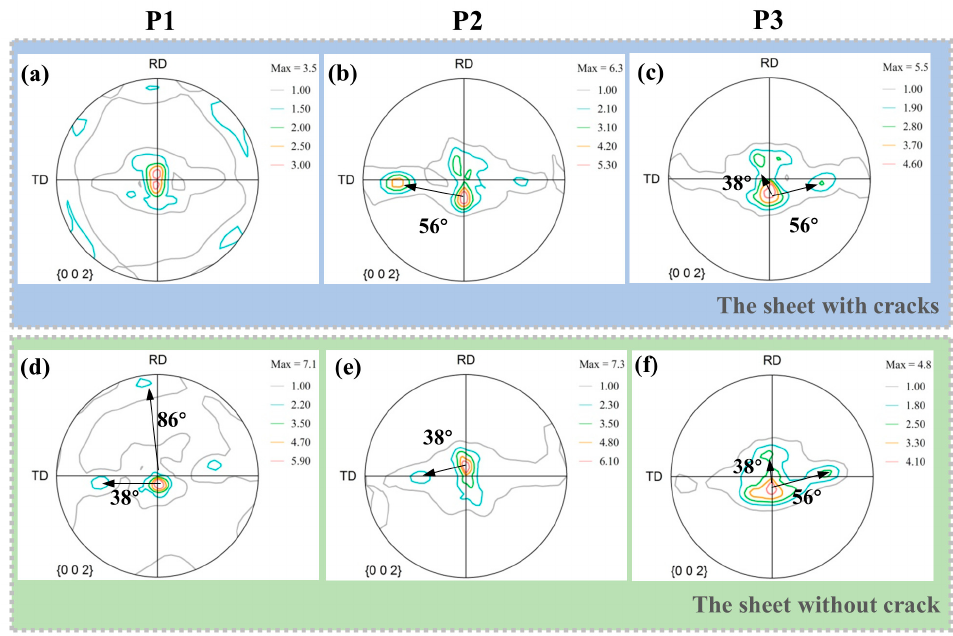
Figure 14. Macrotexture of the sheet with cracks and without crack: ( a , b ) at the edge of the sheet. ( c , d ) at the center of sheet. ( e , f ) at the middle between the edge and the center of sheet.